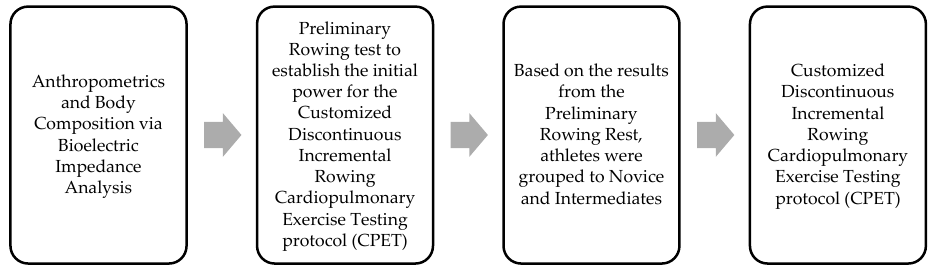
Figure 1. Research design.